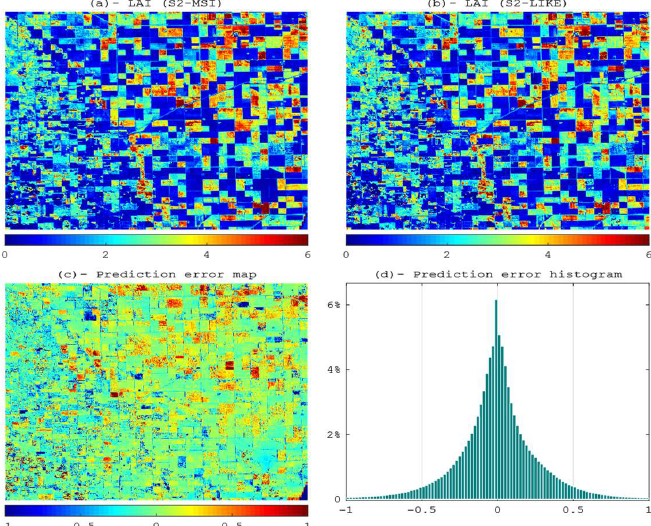
Figure 4. Example of LAI maps derived from S2-MSI ( a ) and S2-LIKE ( b ) images on DOY 175 ( b ), as well as the corresponding LAI prediction error map ( c ) and histogram ( d ).